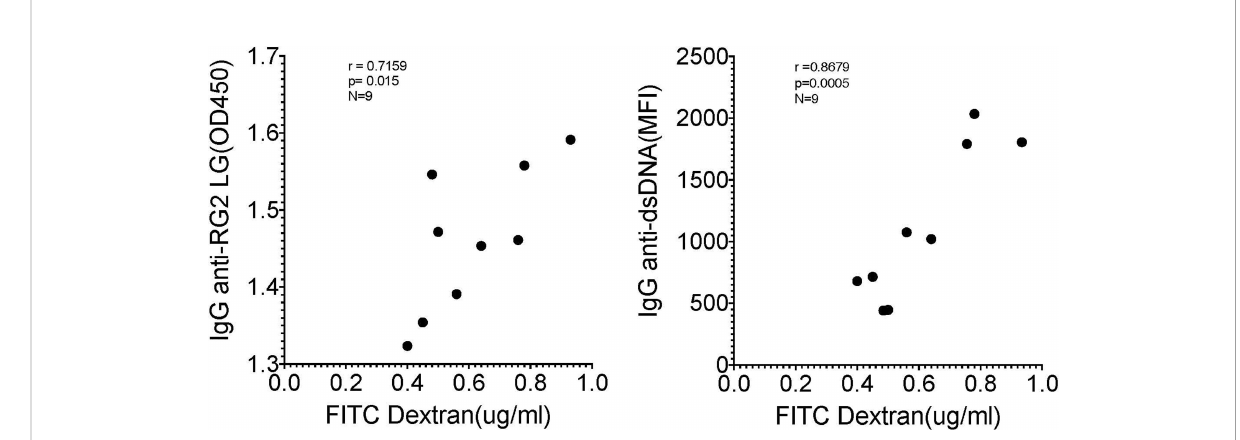
FIGURE 7 Correlation of levels of IgG anti-RG2 strain cell wall lipoglycan antibodies and IgG anti-native DNA autoantibodies correlate with levels of RG colonization induced increased intestinal permeability. Each point represents an individual male and female littermate that had been neonatally colonized with S107-48 RG strain from a GF breeding pair, as depicted in Figures 5, 6B, G, respectively. Results are shown from Spearman correlation analysis. IgG anti-RG2 plasma tested at 1:1000 dilution, and IgG anti-dsDNA was tested at a 1:100 dilution. Samples were studied that were above the 0.22 m g/ml FITC-Dextran ( m g/ml) cut-off that was chosen to represent leakiness (i.e., above values in controls)(N=9). Spearman test used, with r and p values